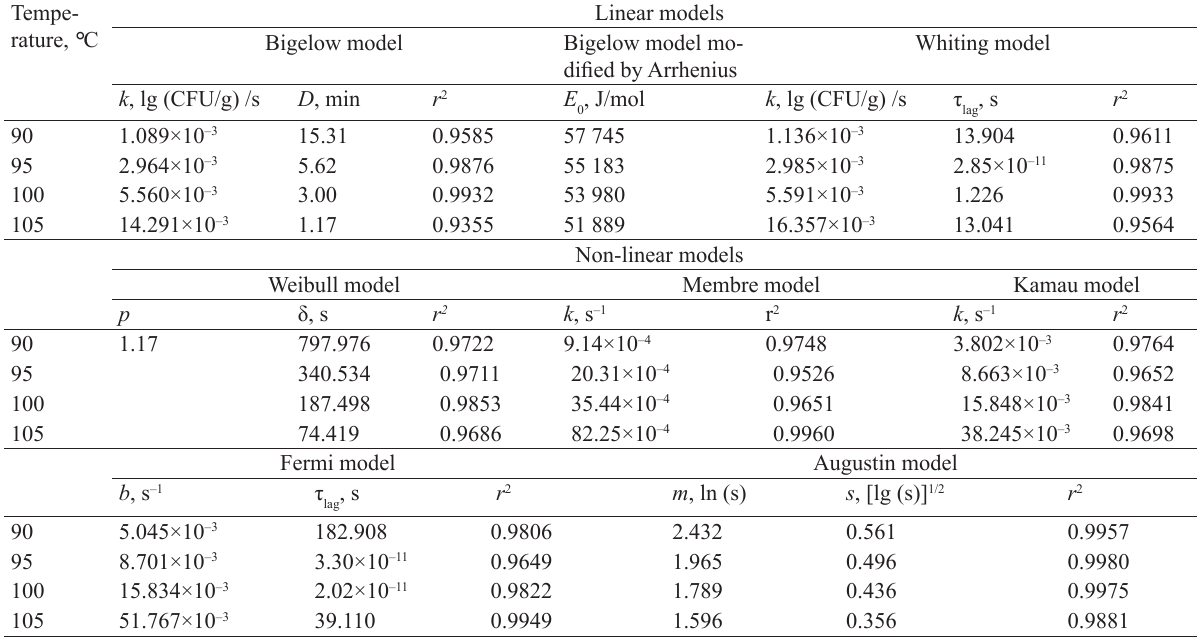
Table 1 Characteristic indicators and determination coefficients corresponding to linear and nonlinear models Tempe-